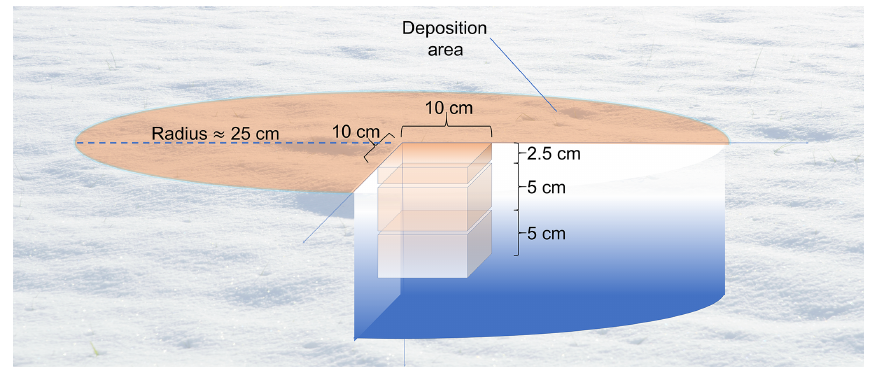
Figure 2. Samples for analysis are collected in three vertical layers. For the deposition area, as depicted here, samples are taken from the center of the area. Samples to represent the natural snowpack are collected similarly upwind of the deposition to minimize contamination. Note: lengths are not to